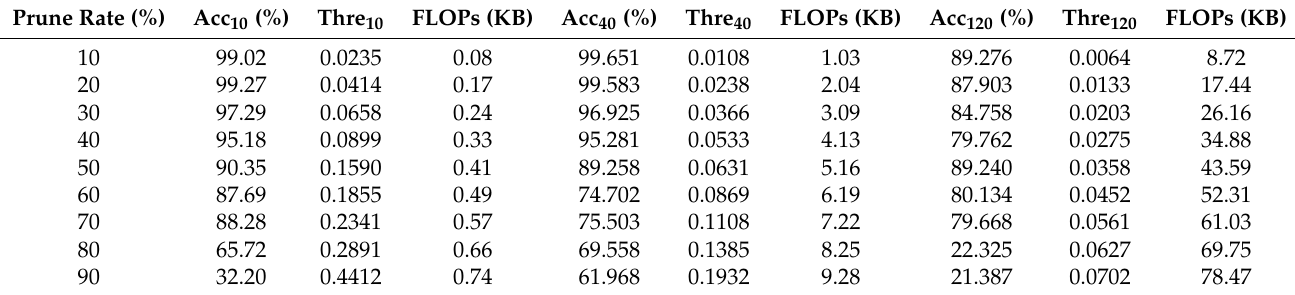
Table 4. Comparison results of pruned model performance. With the increasing pruning rates, the percentage values represent the actual performances in proportion to the original pre-trained models (Acc (%)) and the threshold (Thre) is calculated at different rates in several models. Note that FLOPs represent the size of all pruned